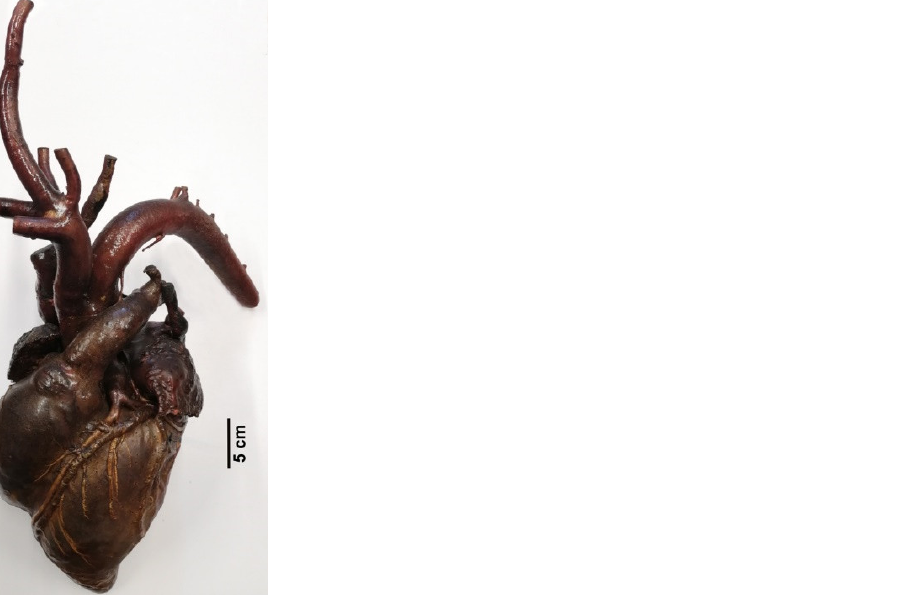
Figure 4. Anatomical preparation of the giraffe’s heart, made in 1853. The specimen is on display at the Natural History Museum of Pisa University.